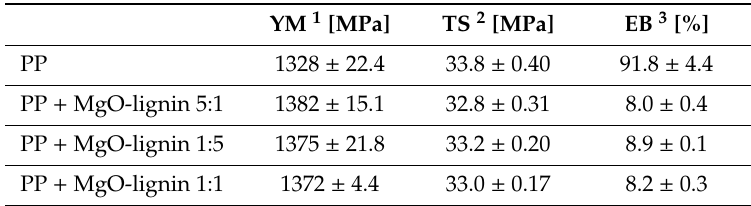
Table 7. Mechanical properties of PP and its